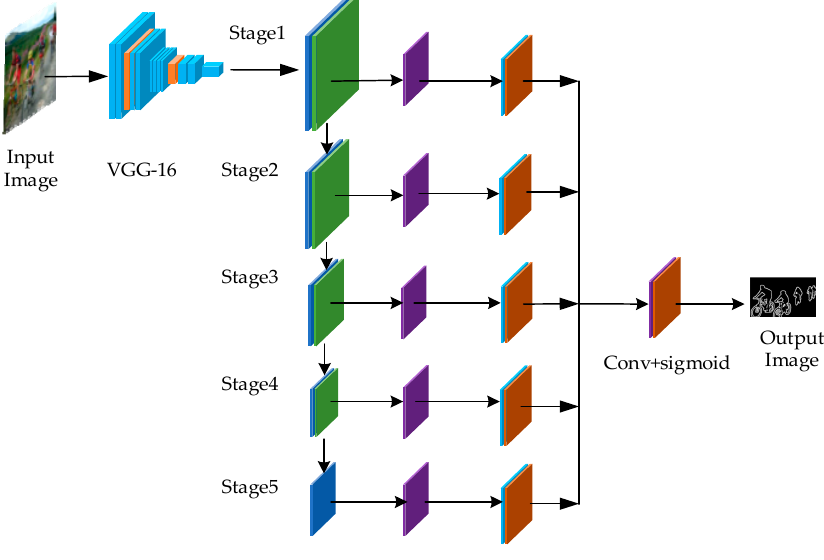
Figure 5. Improved HED network.